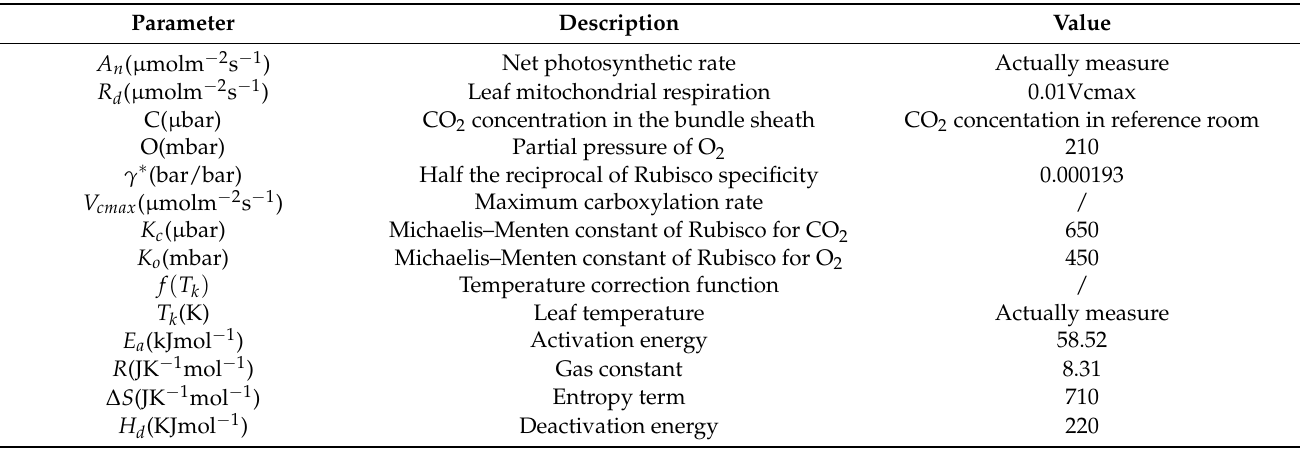
Table 2. Summary of C 4 photosynthesis model parameters at